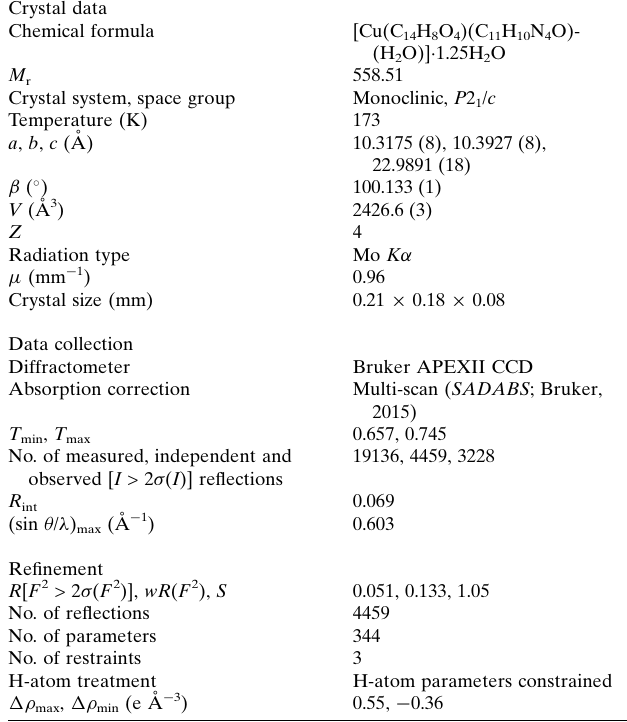
Table 3 Experimental details. Crystal data Chemical